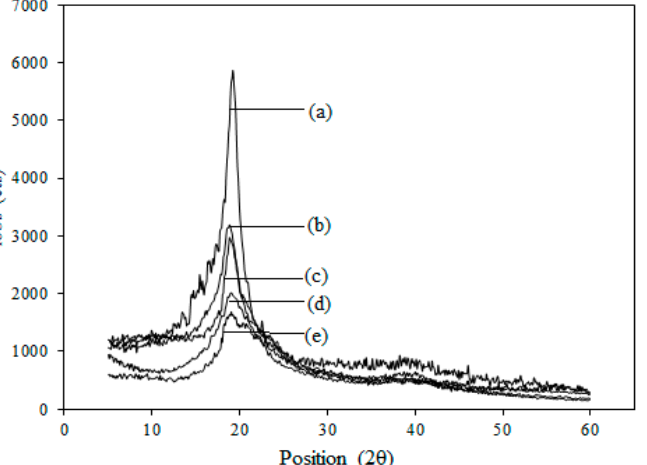
Figure 9. XRD diffractograms of: (a) pristine ETFE film, (b) ETFE- g -P(4-VP)-grafted film, (c) ETFE- g -P(4-VP/1-VIm)-grafted film, (d) acid-doped P(4-VP) membrane and (e) acid-doped P(4-VP/1- VIm) membrane.